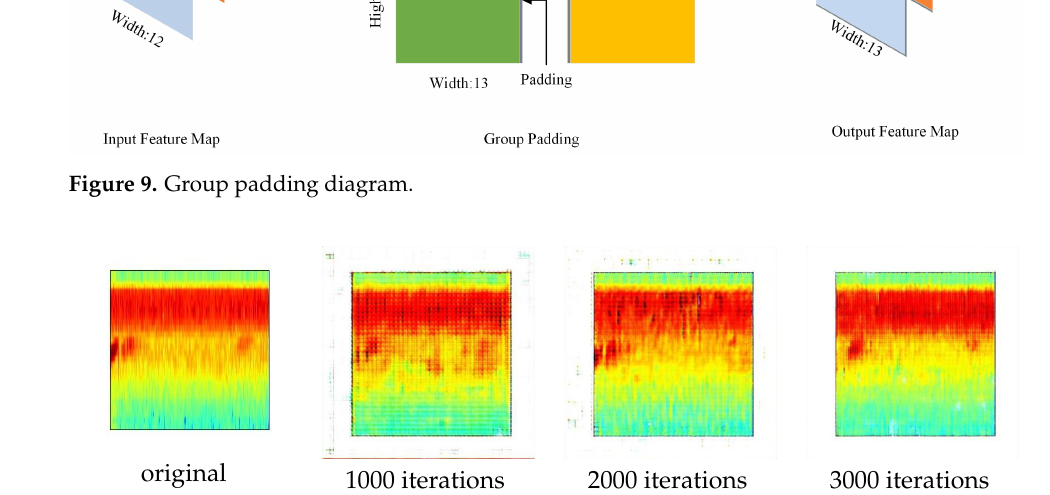
Figure 10. Generated samples under different